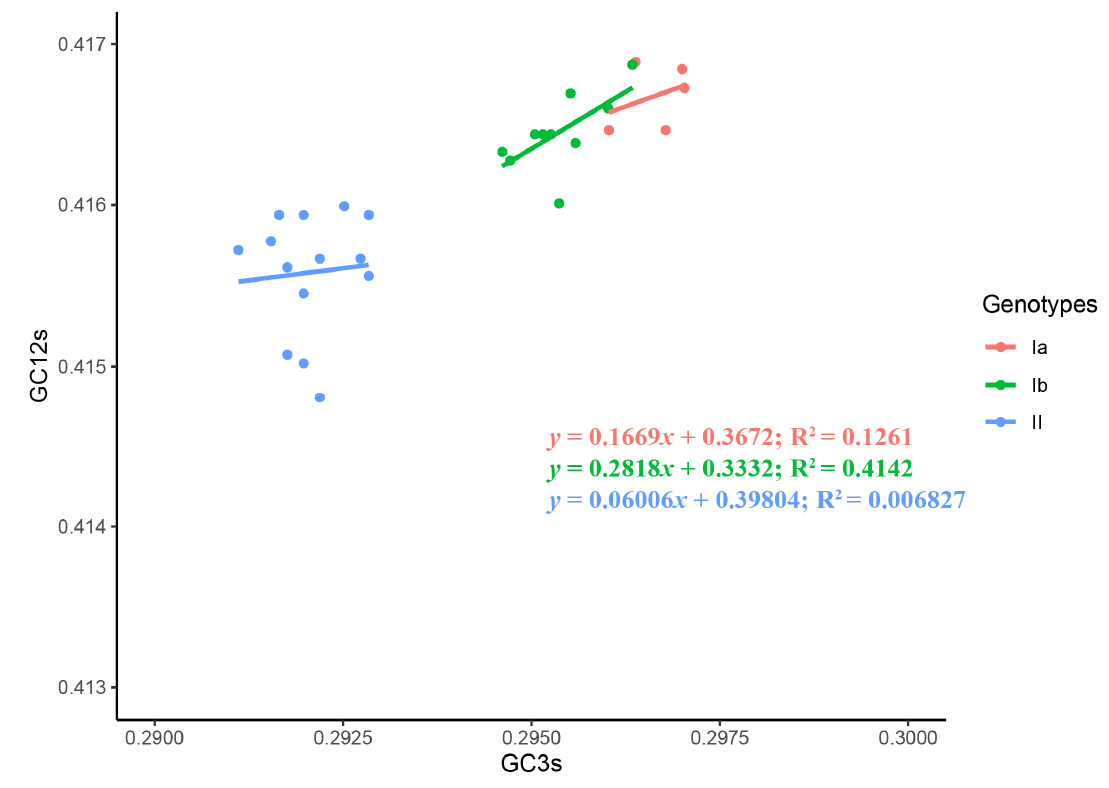
Figure 6. Neutrality analysis of the TGEV complete CDS. The correlation between GC12 and GC3 are represent. Genotypes Ia, Ib, and II are represented in orange, green, and blue, respectively.